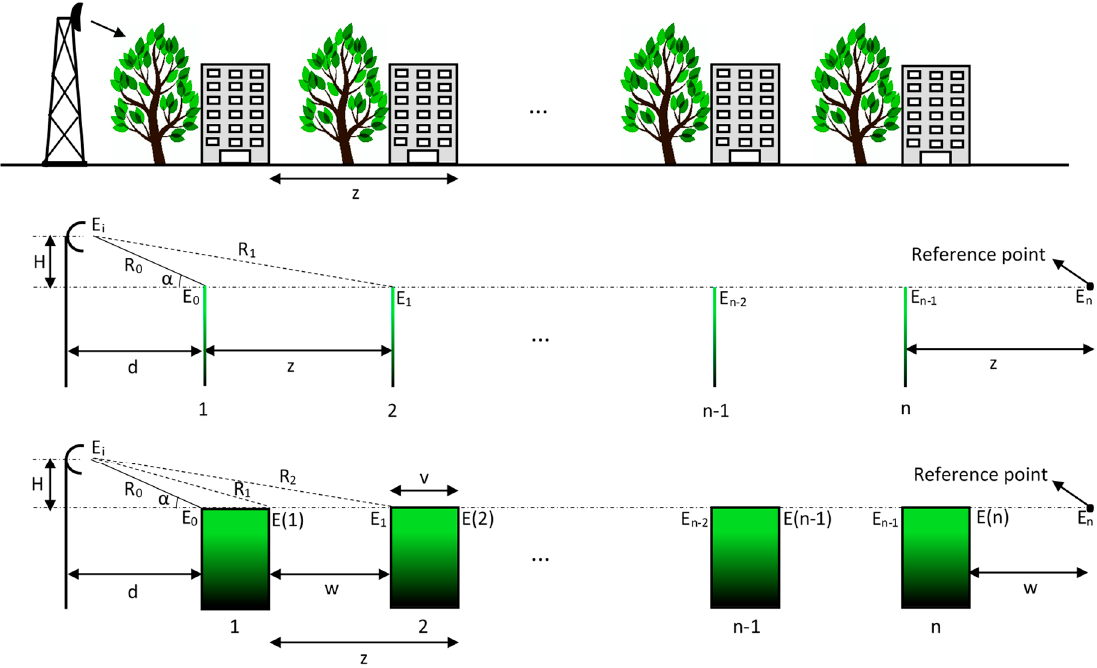
Figure 1. Propagation scenario under consideration for vegetated residential areas having trees and buildings in rows ( top ), and the same environment with buildings shaped as knife edge forms ( middle ) and as rectangular sections ( bottom